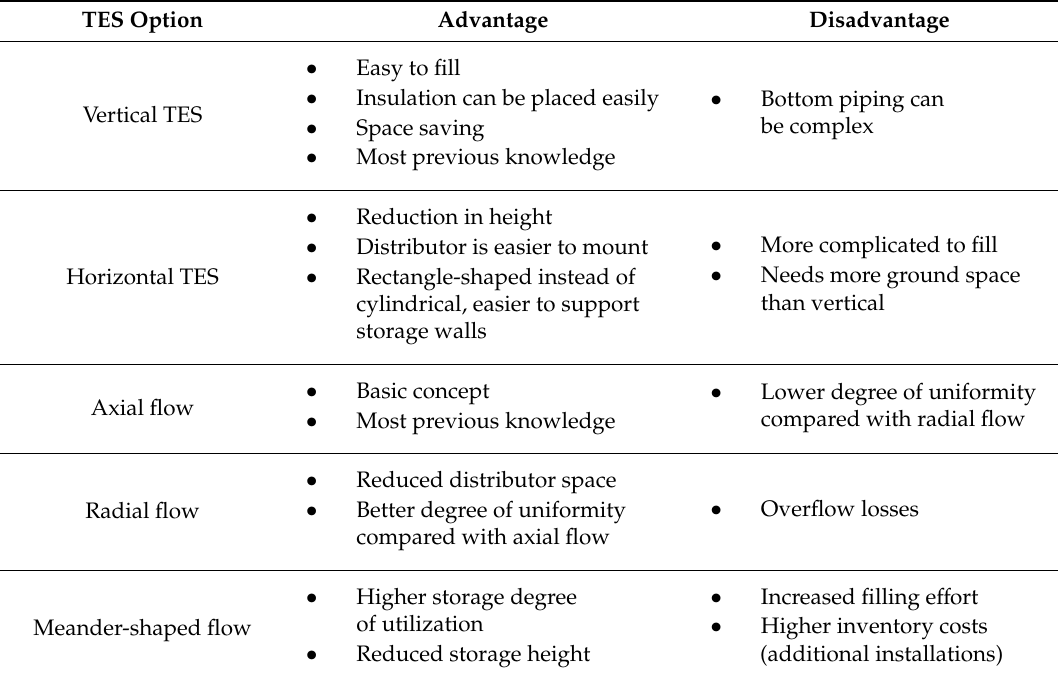
Table 2. Advantages and disadvantages of considered thermal energy storage (TES) designs.